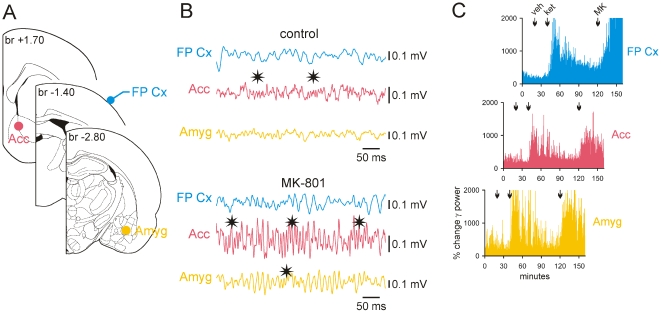
Ketamine or MK-801 increases the amount of γ (30–80 Hz) and higher frequency (81–160 Hz) oscillations in the accumbens and amygdala.These triple recordings were made under fentanyl marcosis. (A): Schematic representation (modified from Paxinos and Watson, 1998) of the recording LFP sites. The location of the recording sites was proved following extracellular application of Neurobiotin made at the end of the recording session. The stereotaxic position of each coronal plane is given in mm relative to bregma (br). (B): 400-ms episodes of LFP (bandpass: 10–200 Hz) recorded ∼15 min after subcutaneous injection of vehicle (saline, 1 ml/kg = control) then ∼30 min after injection of MK-801 (0.08 mg/kg). Note that systemic injection of MK-801 increases the amplitude of γ oscillations in all recorded structures. In the accumbens and amygdala, the amount of high-frequency oscillations (asterisks) is also increased after MK-801 injection. Gamma and higher frequency oscillations are distinguishable. (C): Simultaneous % changes in γ power at the three recording sites after subcutaneous injections of vehicle (veh; 1 ml/kg), ketamine (ket; 5 mg/kg) then of MK-801 (MK; 0.08 mg/kg). Acc, accumbens; Amyg, amygdala; FP Cx, frontoparietal cortex.